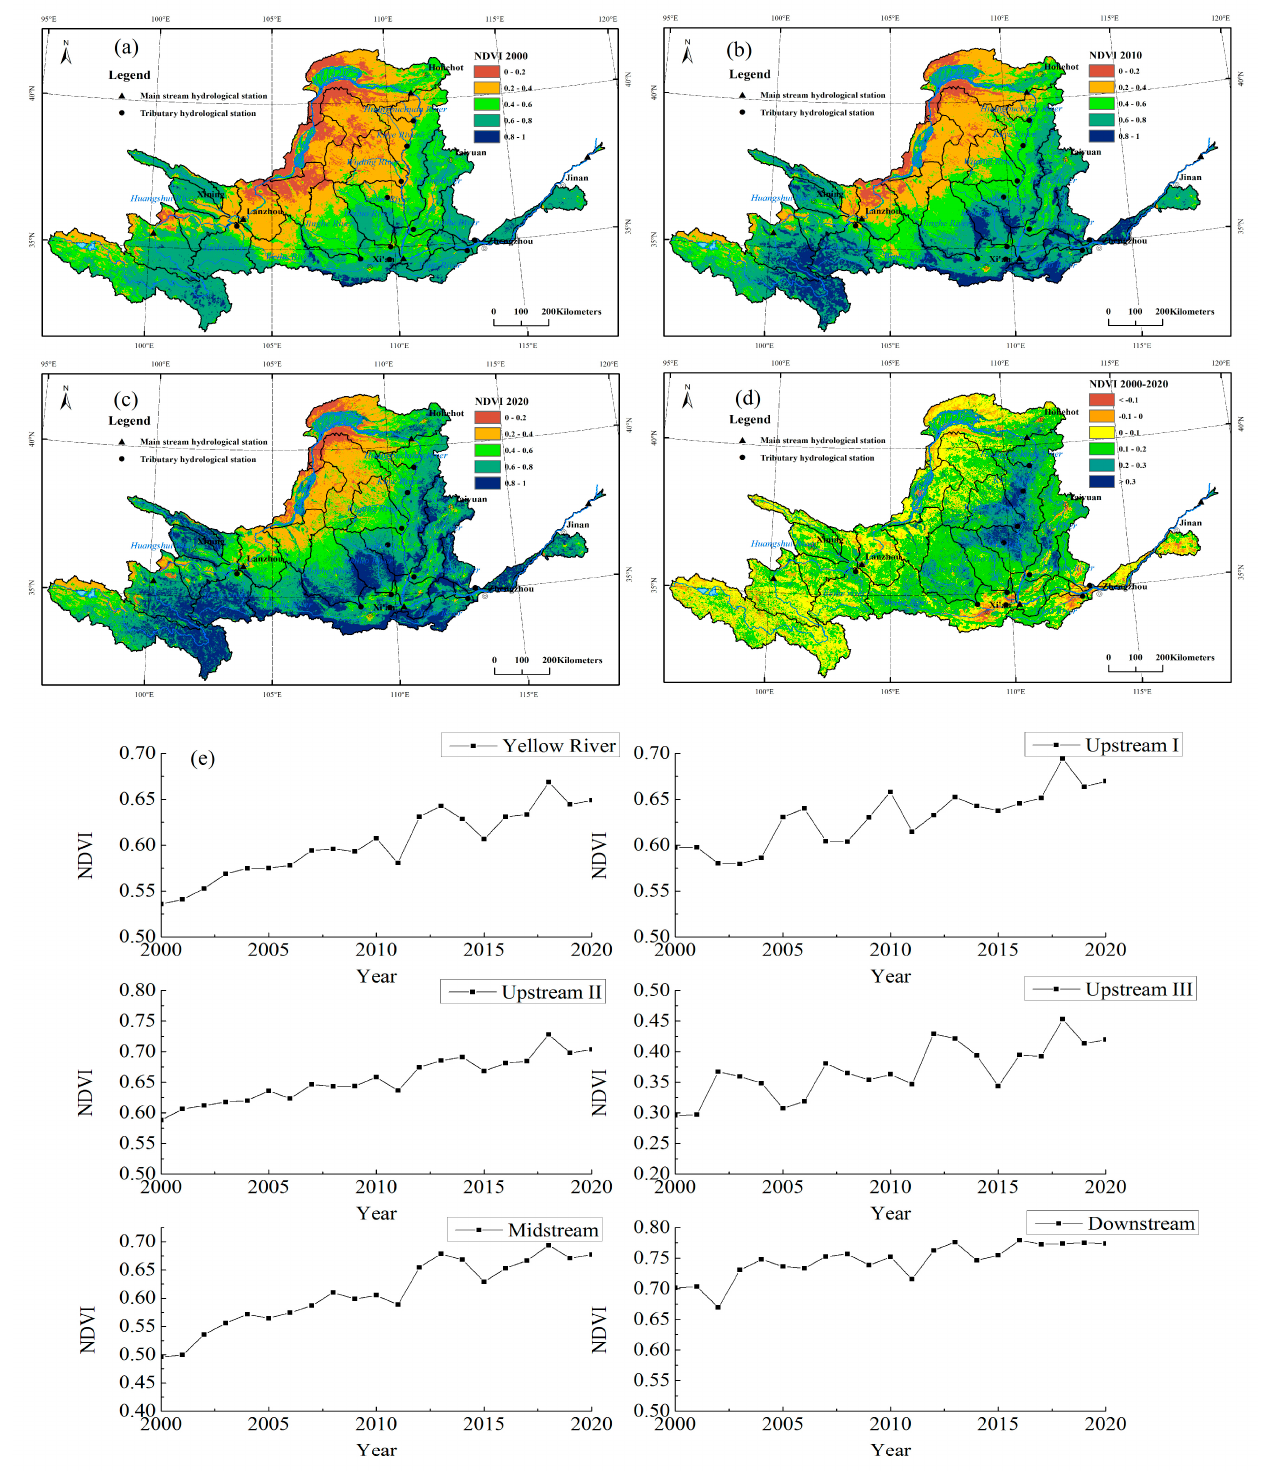
Figure 3. Spatio-temporal changes in the Yellow River basin from 2000 to 2020; ( a – c ) spatial distribution of NDVI values in the Yellow River basin in 2000, 2010, and 2020; ( d ) spatio-temporal variations of NDVI values in the Yellow River basin from 2000 to 2020; ( e ) NDVI variations of each division in the Yellow River basin from 2000 to 2020.